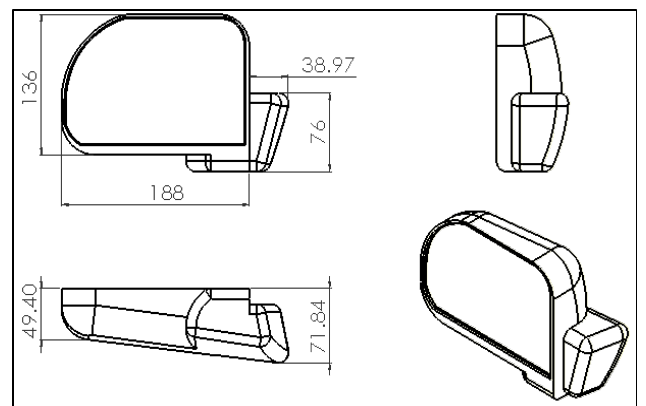
Figure 1. Tiba Mirror modeled in Solidworks Software (unit: milimiter)